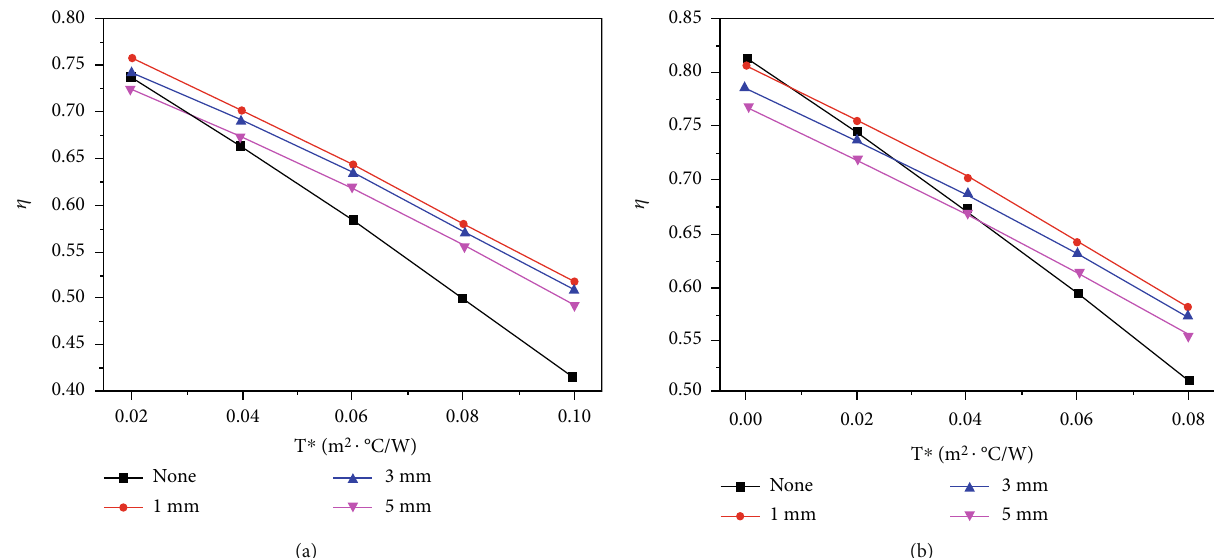
Figure 7: E ff ect of the thickness and environment on e ffi ciency, (a) − 20 ° C and (b) 0 ° C [42].